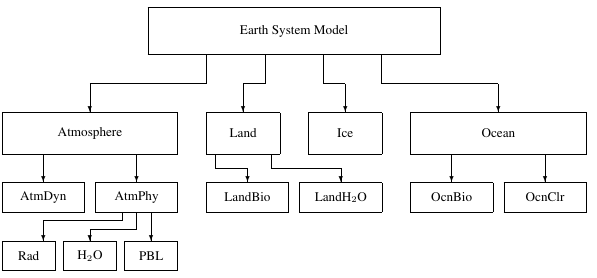
Figure 1. Notional architecture of an ESM: the model is composed of components (or sub-models), each of which is itself composed of components representing a group of one or more related processes. For example, within the atmosphere, the dynamical core (AtmDyn) is only one component, alongside the “physics” (AtmPhy), which itself has subcomponents for radiation (RAD), clouds and moisture (H 2 O), planetary boundary layer (PBL), and so on. The list shown here is clearly not exhaustive, and one could easily imagine further recursive trees within any component